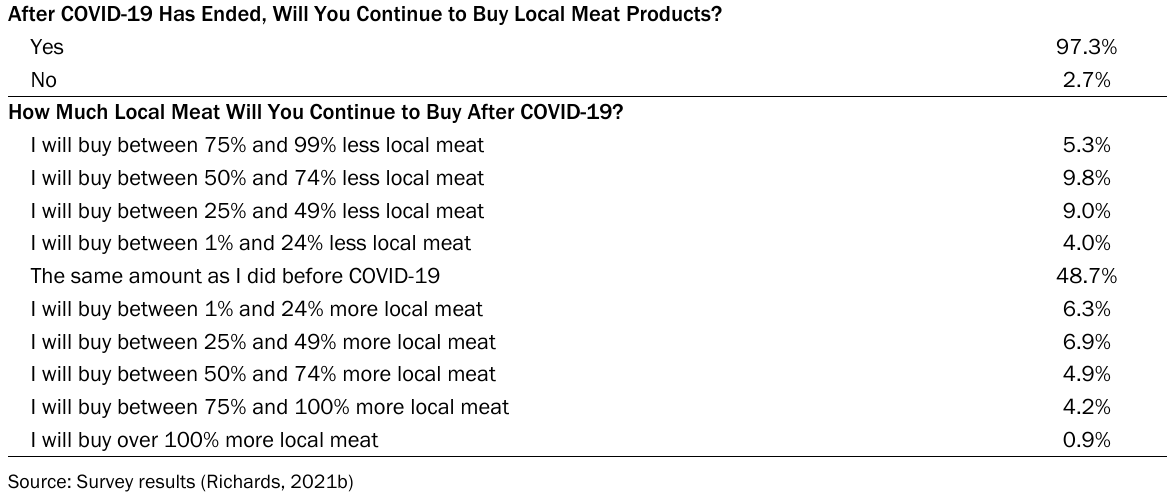
Table 3. Local Meat Purchasing Behavior at Home After COVID-19 ( n